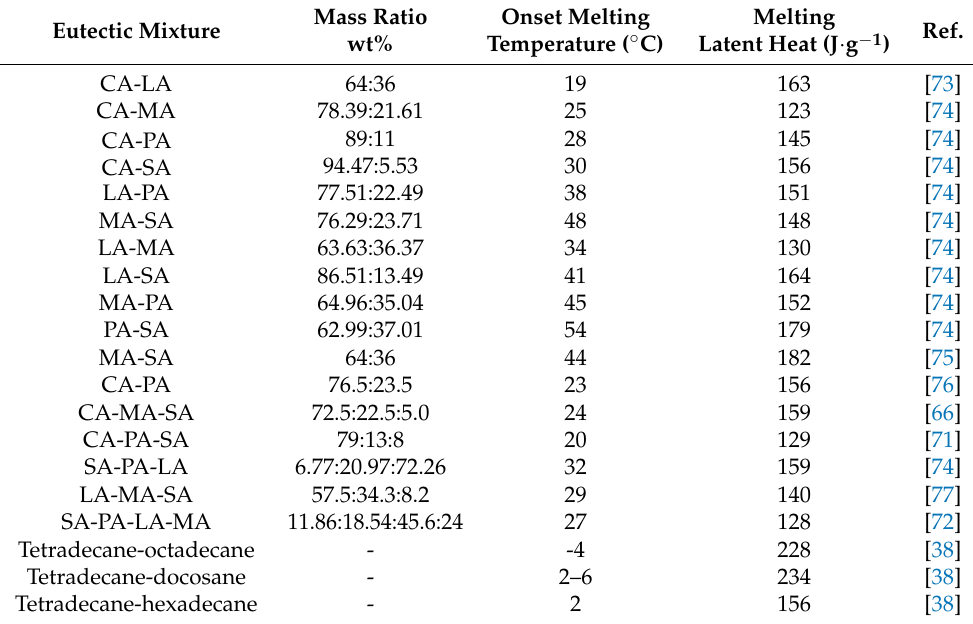
Table 2. Examples of PCMs eutectic mixtures and their properties. Eutectic